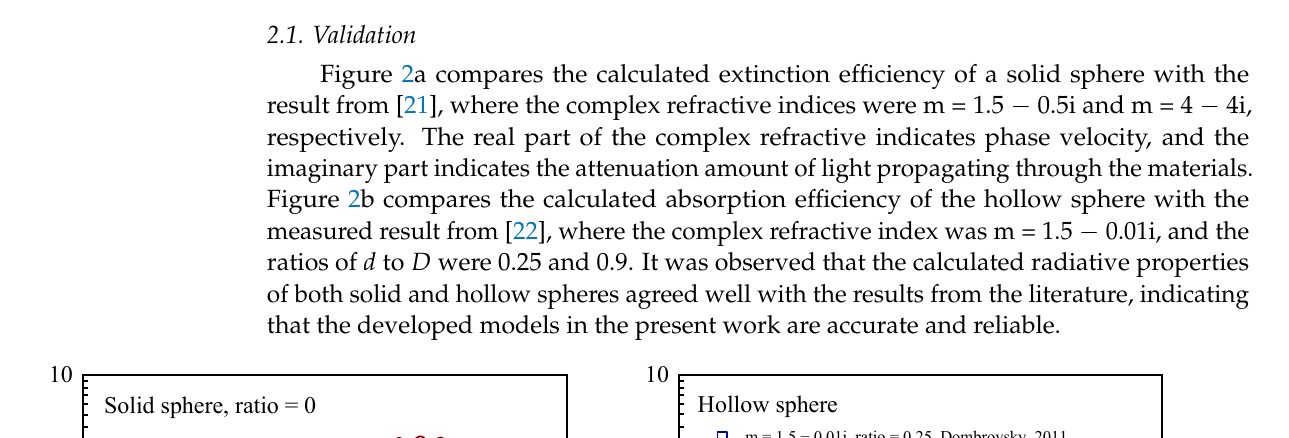
Figure 1. Radiative properties of silica aerogel matrix with a density of 130 kg/m 3 . ( a ) Extinction coefficient vs. wavelength, and ( b ) Rosseland mean extinction coefficient vs. temperature.